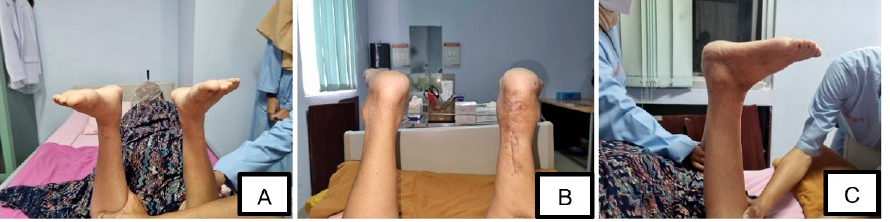
Figure 4. Postoperative clinical condition: ( A ) surgical wound closure, ( B ) fixation at 150° plantarflexion.